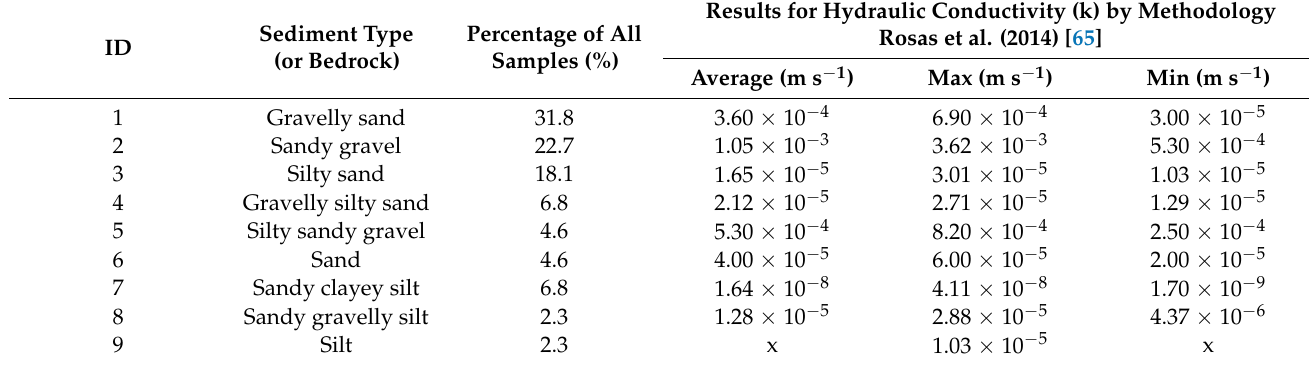
Table 1. The hydraulic conductivity calculated for the 9 sediment types identified, representing all samples collected in the study area.